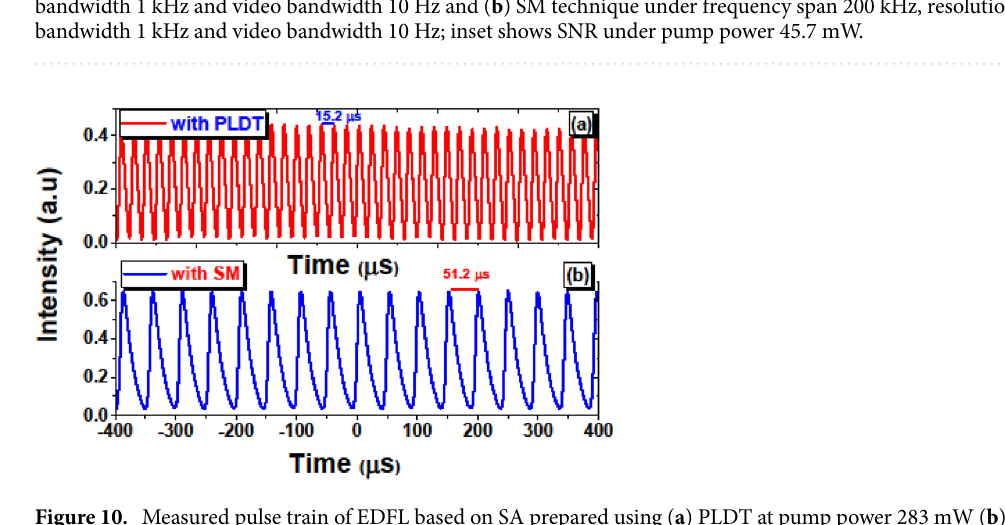
Figure 10. Measured pulse train of EDFL based on SA prepared using ( a ) PLDT at pump power 283 mW ( b ) SM technique at pump power 45.7